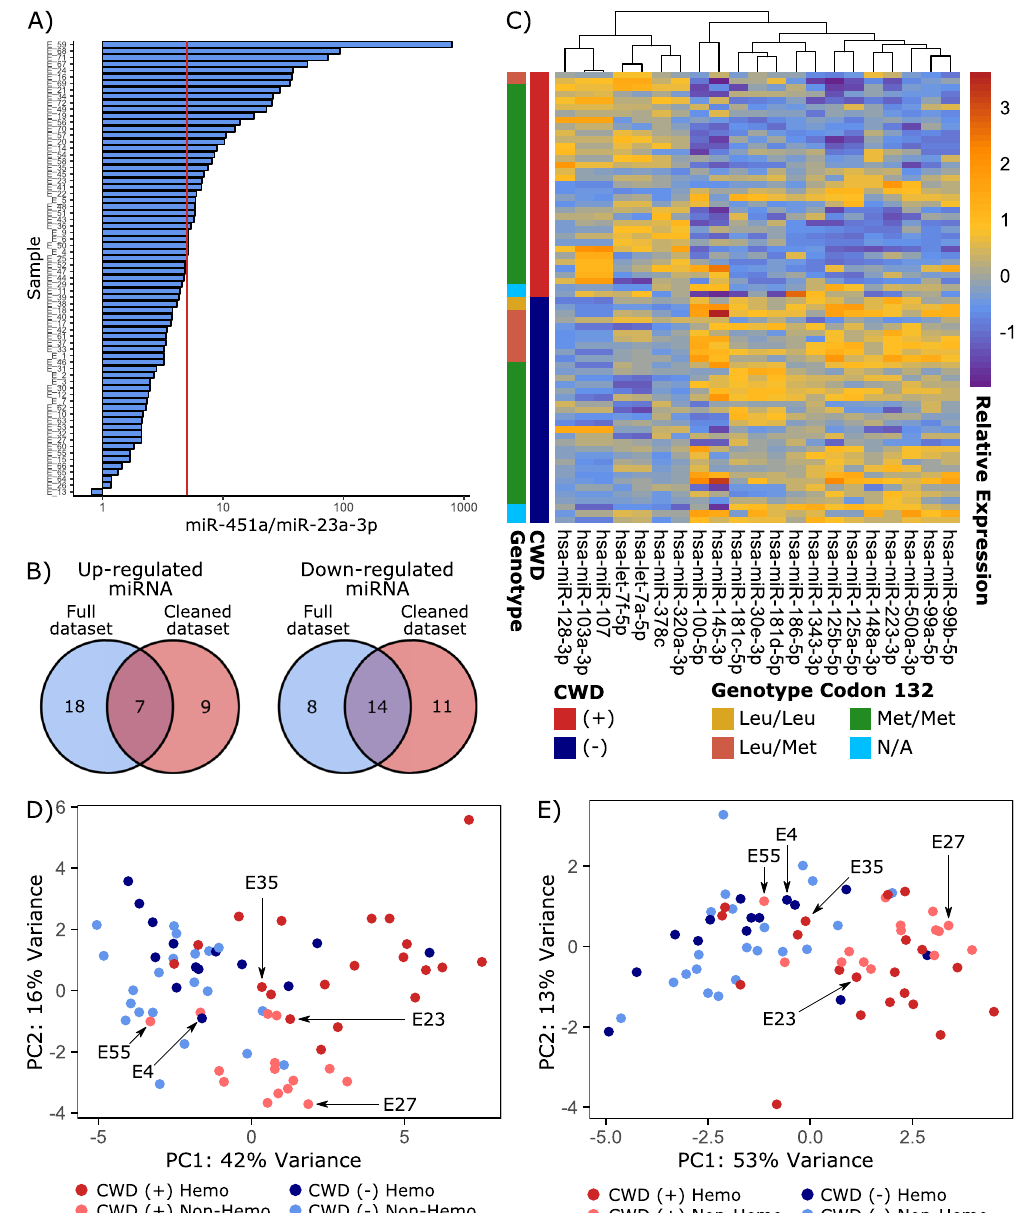
Figure 3. Serum miRNA are biomarkers of CWD in elk. A subset of serum miRNAs are altered in CWD infected elk regardless of the presence of hemolysis in serum. ( A ) A cleaned elk dataset was constructed by removing hemolyzed samples using a strict miR-451a/miR-23a-3p cutoff of 5. ( B ) 21 miRNAs were detected as differentially expressed regardless of the presence of hemolyzed serum samples in the dataset. ( C ) Hierarchical clustering of the putative 21 serum miRNA biomarkers highlights their altered abundance elk positive for CWD by IHC, and their expression is not influenced by the genotype at codon 132 of PrP. ( D ) Elk serum samples cluster based on both disease status and presence of hemolysis when the list of genes altered in the full dataset is used for PCA. ( E ) Elk serum samples cluster based on disease status, but not hemolysis, when the 21 putative CWD biomarkers are used for PCA. The IHC ( − ) elk that was ( + ) by PMCA (E4) and the four IHC ( + ) elk that were ( − ) by PMCA are highlighted on the PCA